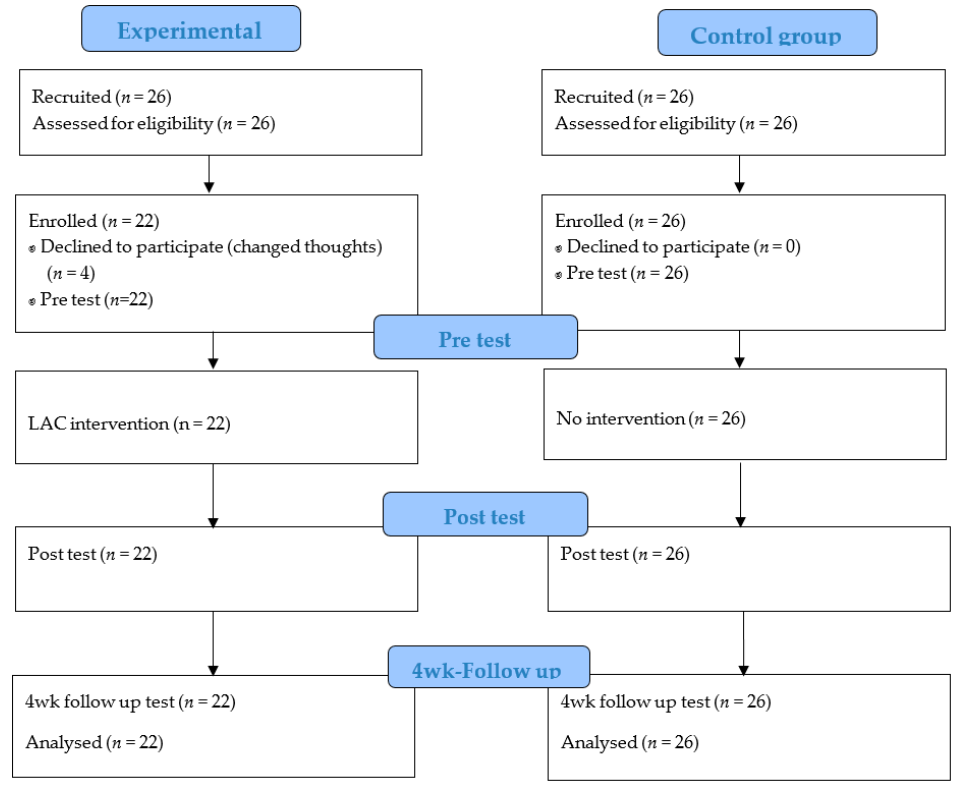
Figure 1. Flow chart of the participants’ recruitment and participation.